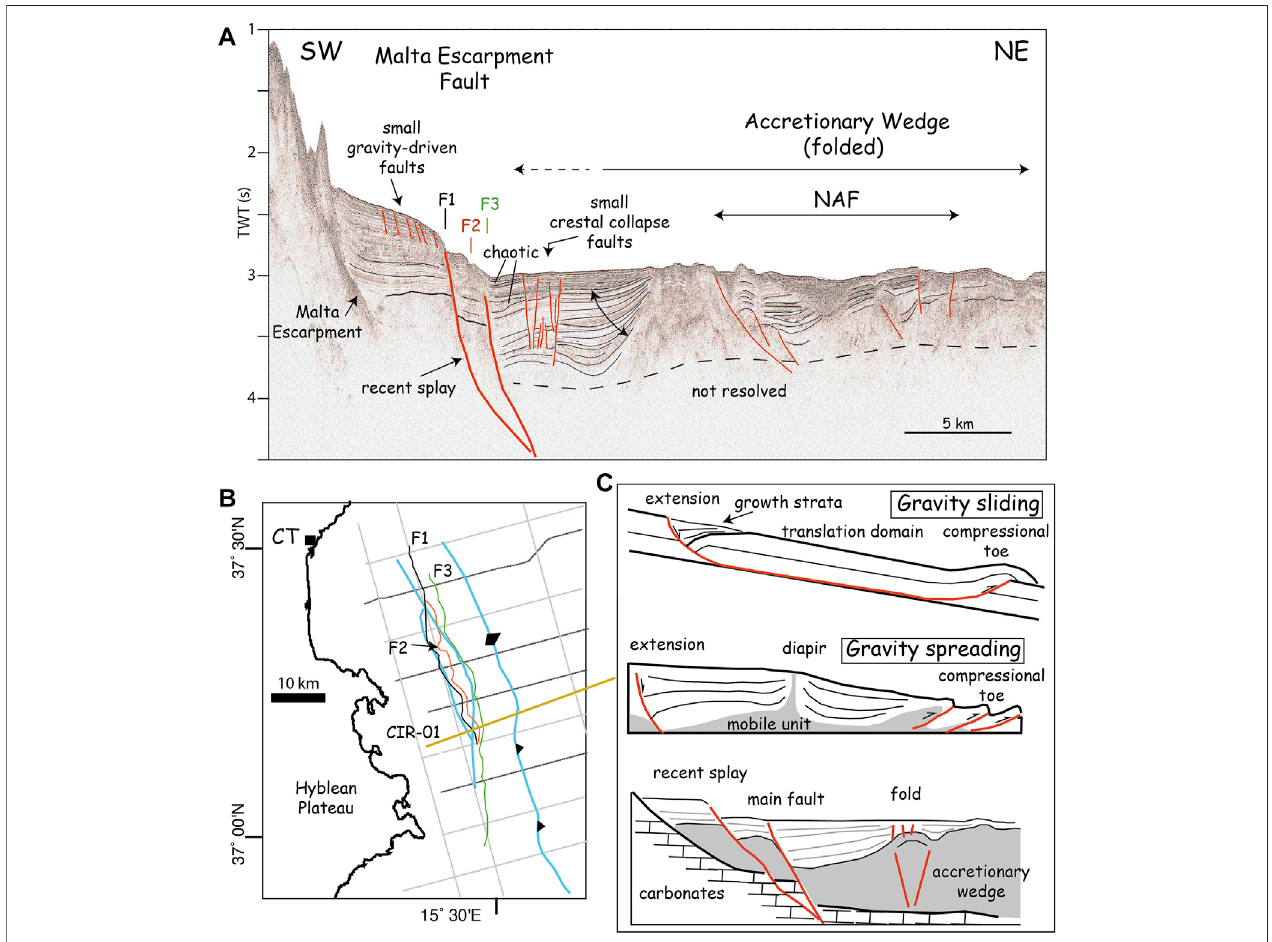
FIGURE 1 | (A) Interpretation of pro fi le CIR-01. The interpretation is only coarse because of the low resolution of the publicly available CIR pro fi les (Gutscher et al., 2017).Itmaybeworthnotingthatthetimescaleofpro fi leCIR-01presentedbyGAMBisshiftedupwardof1 sTWTwithrespecttotheoriginaldata;thereasonforthisis not explained. F1, F2 and F3 indicate the position of the faults ofGAMB, though the evidence for F2 is very poor. The connection at depth of the two faults traced on the Malta Escarpment is based on the MESC pro fi les, where this relationship is best viewed due to their greater penetration (Argnani and Bonazzi, 2005). The arrow- ended line indicates the growth strata to the west of the anticline. Note the extensive erosion at sea fl oor. NAF, North Alfeo Fault. (B) Simpli fi ed tectonic map of the northernsectoroftheMaltaEscarpmentshowingthefaultsmappedby(ArgnaniandBonazzi,2005)inblueandthoseofGAMB(F1,F2andF3).Notetheoverallsimilarity inthefault traces.Thelimited extent ofF2and itspositionveryclose toF1suggestthatitisahierarchicallylowerstructure,thoughitsoccurrenceisdoubtful(seeGAMB, SupplementaryFigure2 ).Lineswithtriangles:thrustsandreversefaults,lineswithdiamonds:anticlines.TheMESCseismicgridisshowningray,withthelinesusedby GAMB in dark gray. The trace of pro fi le CIR-01 is in orange. (C) Upper panel: sketch of gravity sliding, showing the translation zone without subsidence with respect to theregionalreference.Middlepanel:sketchofgravityspreadingthatcanoccurinheavilysedimentedmarginswithamobileunit(overpressuredshaleorsalt)atthebase. Lower panel: tectonic relationships along the Malta Escarpment assuming that faulting is younger than the emplacement of the accretionary wedge, which continues to be shortened (following Argnani and Bonazzi, 2005). Panels (A,B) are after (Morley et al., 2011).